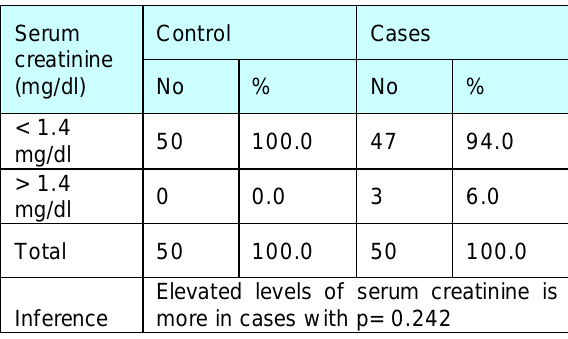
Figure 2: Gender distribution of subject studied Table 1: Levels of serum creatinine in case and